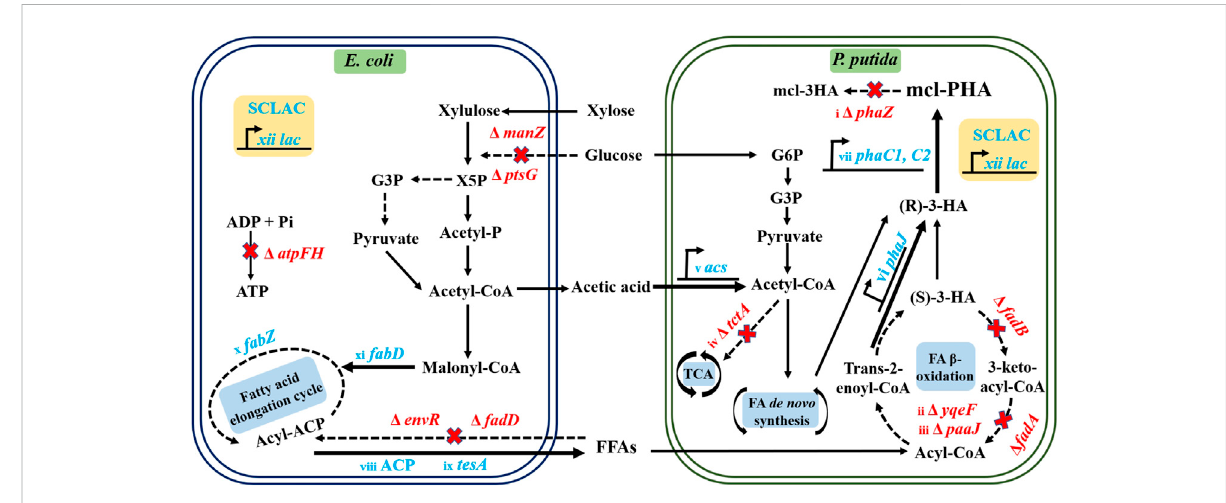
FIGURE 1 Schematic diagram of the metabolic engineering protocol for the production of mcl-PHA by the P. putida - E. coli microbial consortium. Acronyms:X5P,Xylulose5-phosphate; G3P, Glyceraldehyde-3-phosphate;Acetyl-P, Acetyl Phosphate;G6P,Glucose-6-Phosphate.Thered words in the biosynthetic pathway indicate the deletion of corresponding genes. The blue words indicate the overexpression of corresponding genes. The related genetic engineering represented by i~xii was conducted in this